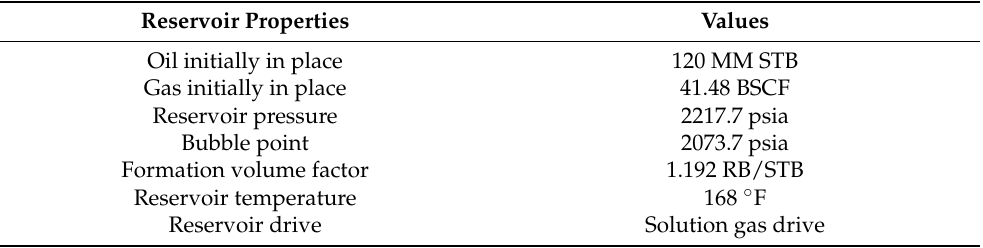
Table 1. Initial reservoir conditions.